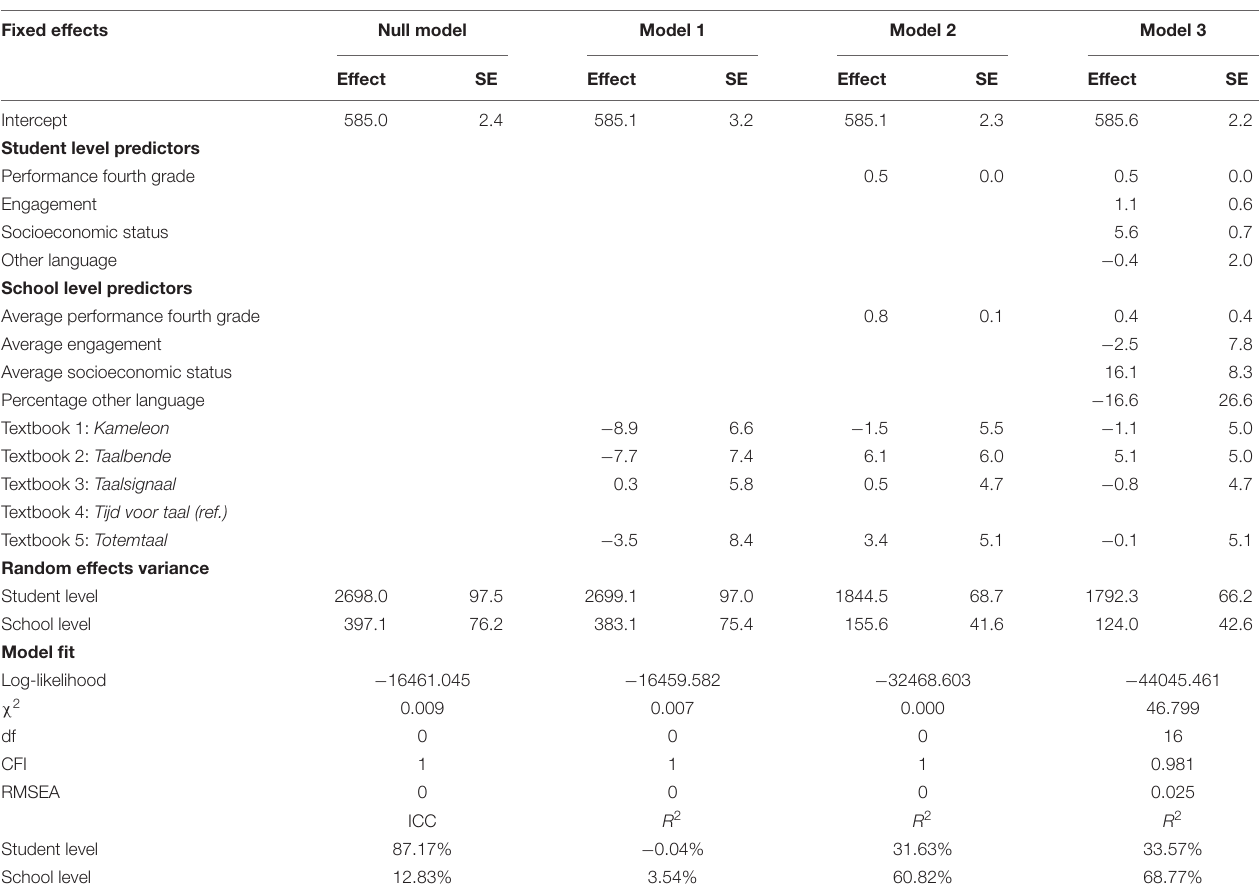
TABLE 4 | Coefficients multilevel autoregression model for reading